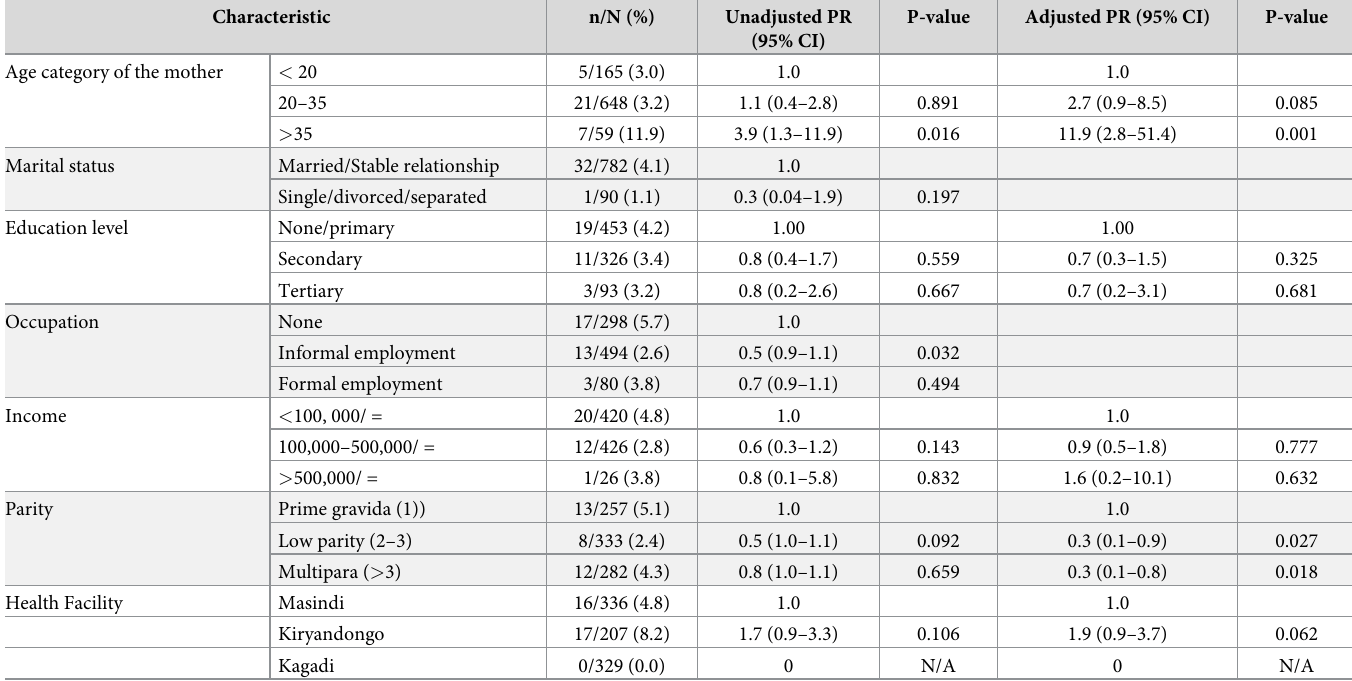
Table 4. Factors associated with appropriate postpartum